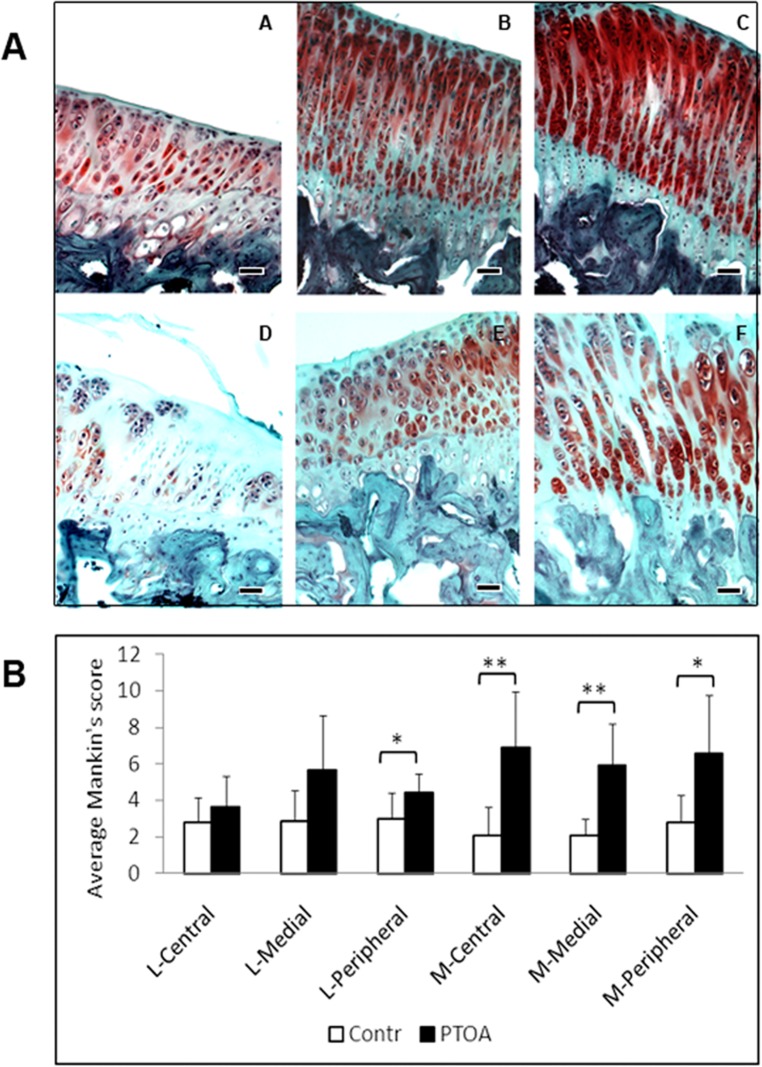
A) Histology of PTOA knees.A, B and C are the peripheral, central and medial regions of the medial plateau in the control knees. D, E, and F are the peripheral, central and medial regions of the medial plateau of the PTOA knees, respectively. While the cartilage in the control knees is intact and uniformly stained for extracellular matrix, the cartilage in the PTOA joints shows clustering cells, decreased and uneven staining of proteoglycans, and surface fibrillation (Safranin-O/Fast green/Hematoxylin staining). B) Mankin’s scores of six selected locations on the tibial plateau of the PTOA and control knees. PTOA developed in all three locations on the medial plateau and the peripheral area of the lateral plateau after four weeks of ACL transection and meniscectomy. Note: * indicates p < 0.05; ** p < 0.001. L = lateral plateau; M = medial plateau; bar = 20μm.